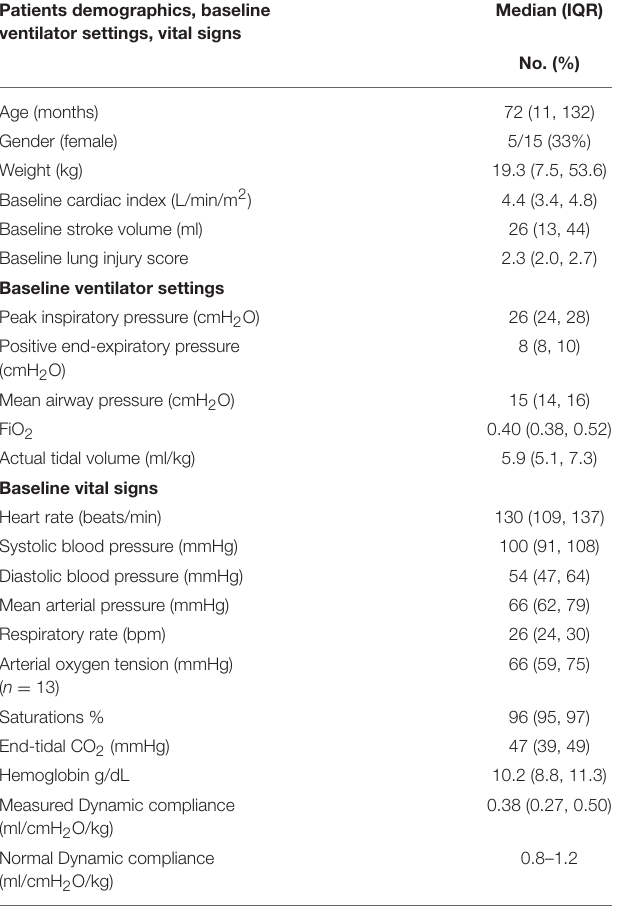
TABLE 1 | Baseline demographics and characteristics. Patients demographics, baseline ventilator settings, vital signs